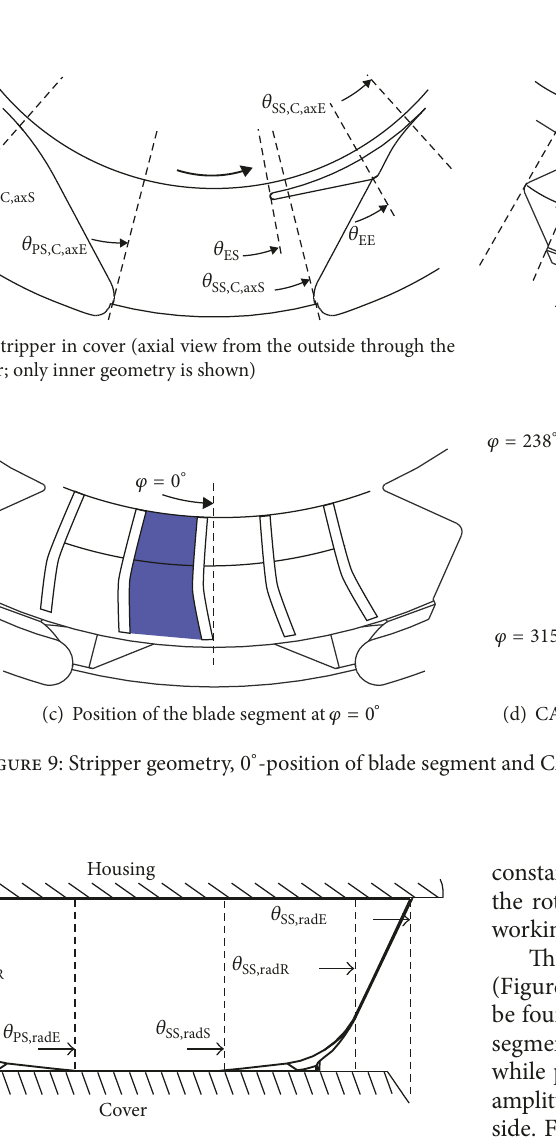
Figure 10: Radial stripper (view in positive radial